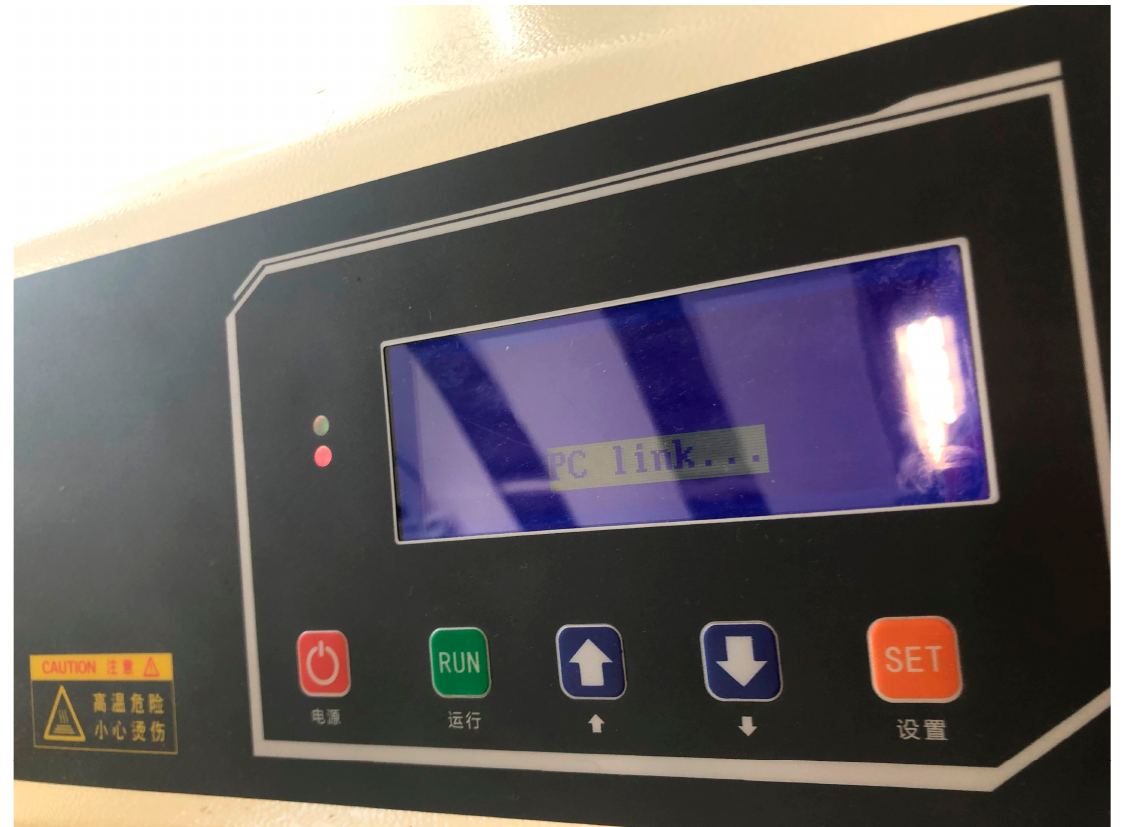
Figure 9. Reflow Oven’s Liquid Crystal Display (LCD) confirms successful “PC-link” mode entered. Red Light Emitting Diode (LED) to the left of the display indicates resistance is currently active and temperature increase is occurring.